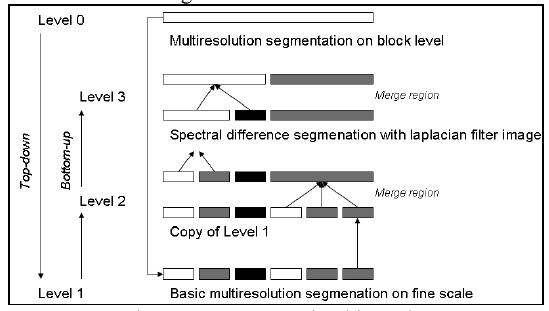
Figure 4. Segmentation hierarchy